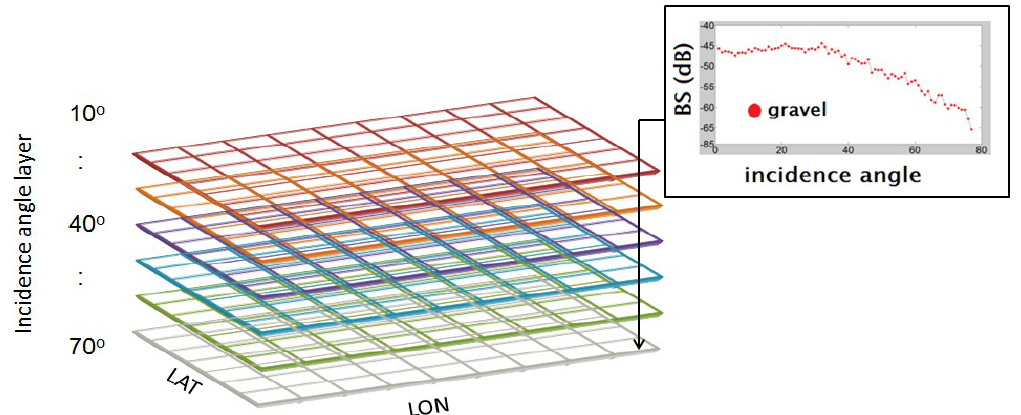
Figure 1. Example graph of the hyper-angular cube (HAC) matrix showing the stack of angular backscatter layers and an angular response derived from a single cell.